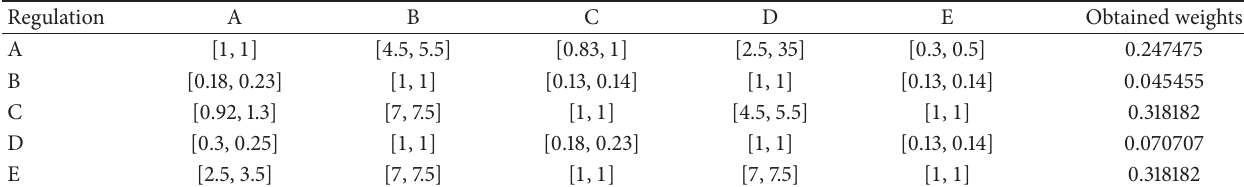
Table 17: The interval approximation choices referring to the regulation subcriteria.